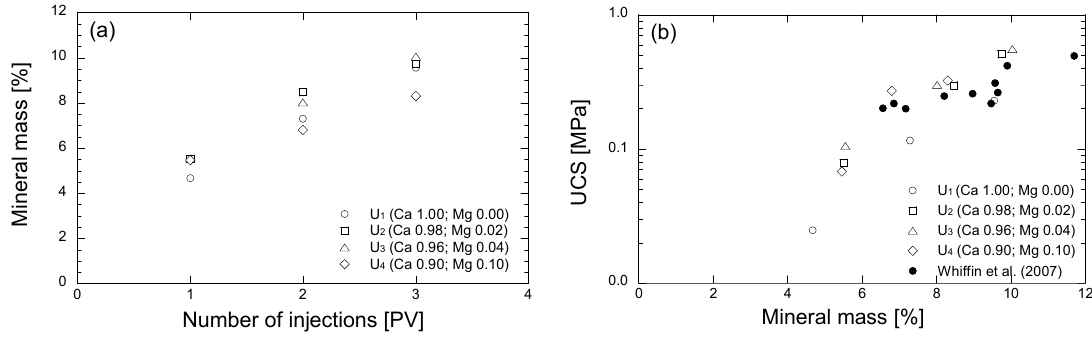
Figure 10. Results of PVC cylinder tests: ( a ) mineral mass in various number of injections; and ( b ) relation between mineral mass and UCS.